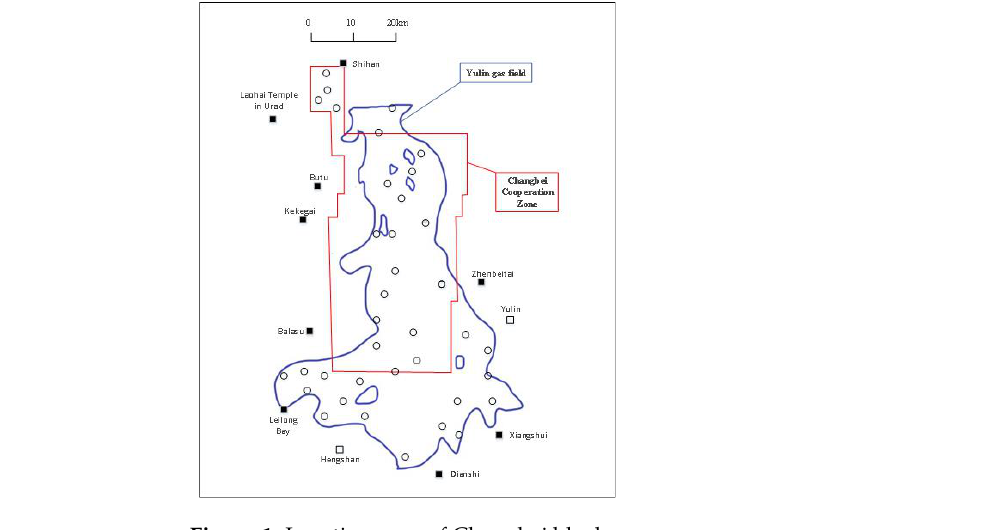
Figure 1. Location map of Changbei block.